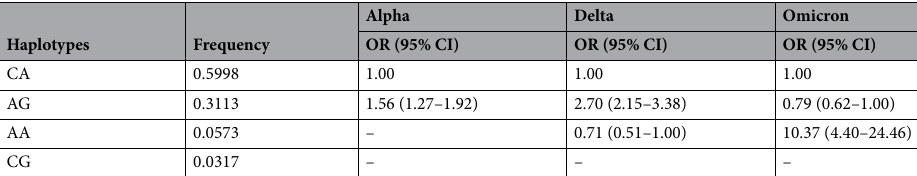
Table 4. SARS-CoV-2 variants and ApaI rs7975232 and BsmI rs1544410 haplotypes. SARS-CoV-2 severe acute respiratory syndrome coronavirus 2, SNPs single nucleotide polymorphisms, OR odds ratios, CI confidence